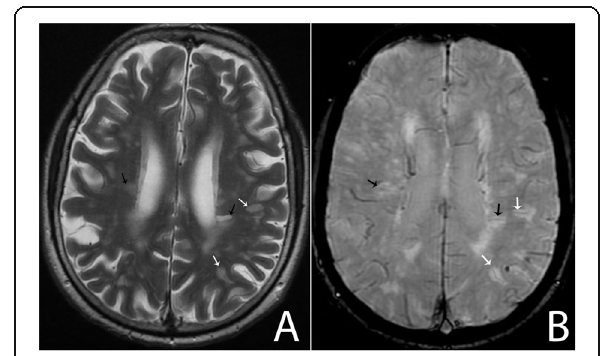
Fig. 7 A 63-year-old female patient with cerebral small vessel disease. Axial ( a ) T2WI image show multiple hyperintense periventricular (black arrows) and juxta-cortical lesions (white arrow). On corresponding ( b ) SWI image, a thin hypointense line representing the CVS is seen in the periventricular (black arrows) and juxta-cortical lesions (white arrow)